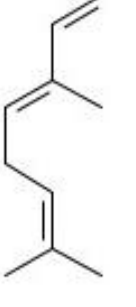
Figure 6. Chemical structure of β